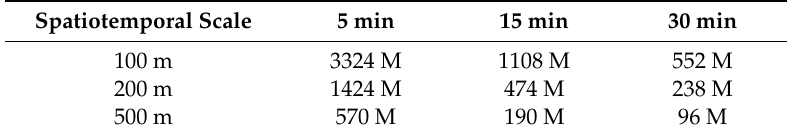
Table 3. Required storage space of middle-tier data for various finest spatiotemporal scale unit for a dataset in 3221 M